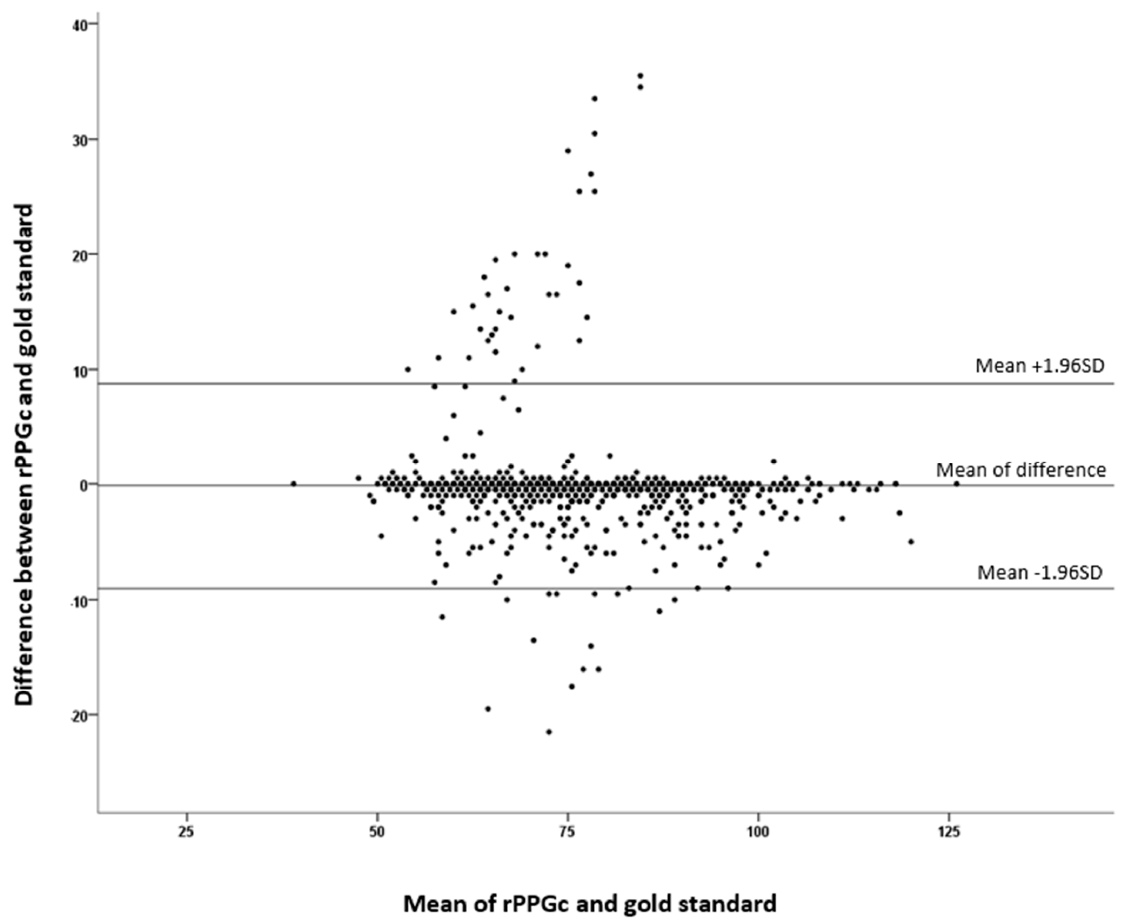
Figure 2. Bland–Altman plot showing the agreement between rPPGc and the control at 60 s. Table 2. Intersystem concordance between rPPGc and gold standard as a function of age. Criteria such as age and gender had no effect on measurement precision. In fact, the average ICC for women was 0.858, with 95% being in the CI [0.830:0.881], whilst that for n (%) men was 0.908 with 95% being in the CI [0.891:0.923]. Considering both genders, the ICC was always higher than 0.80 for patients aged between 18 and 92 years (Table